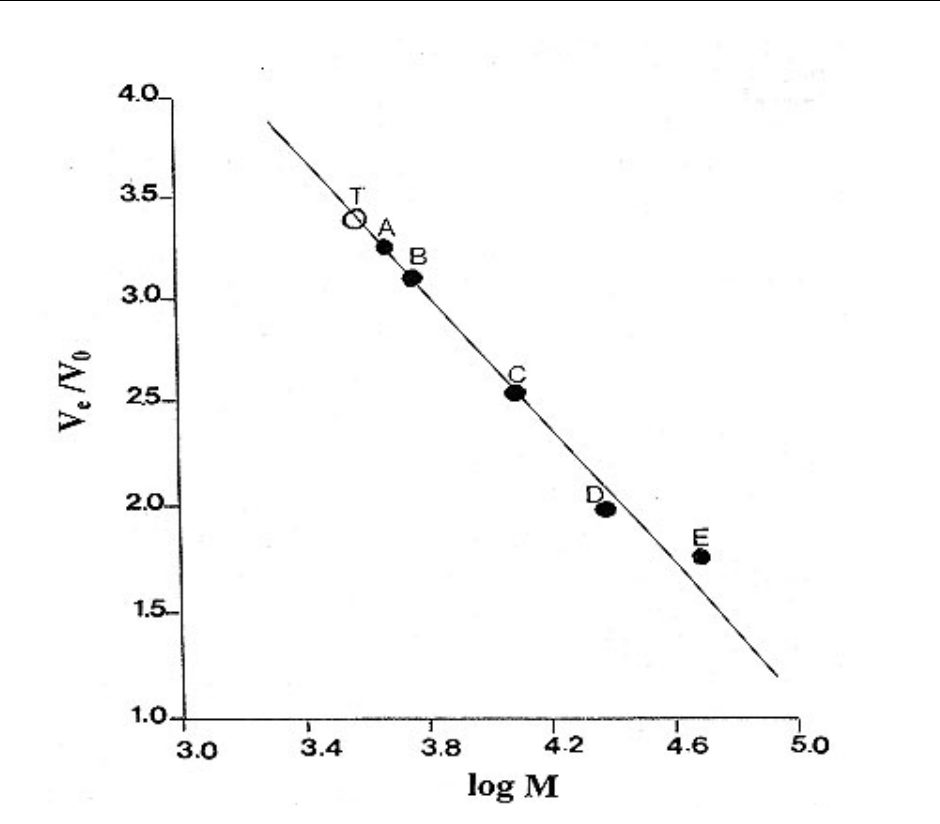
Figure 4: Calibration curve for the determination of the toxin molecular weight at pH 8.5 by gel filtration chromatography on Sephadex G-75. Marker proteins used for calibration: A: insulin (5,600); B: aprotinin (6,500); C: lysozyme (14,300); D: carbonic anhydrase (29,000); E: ovalbumin (45,000); T: